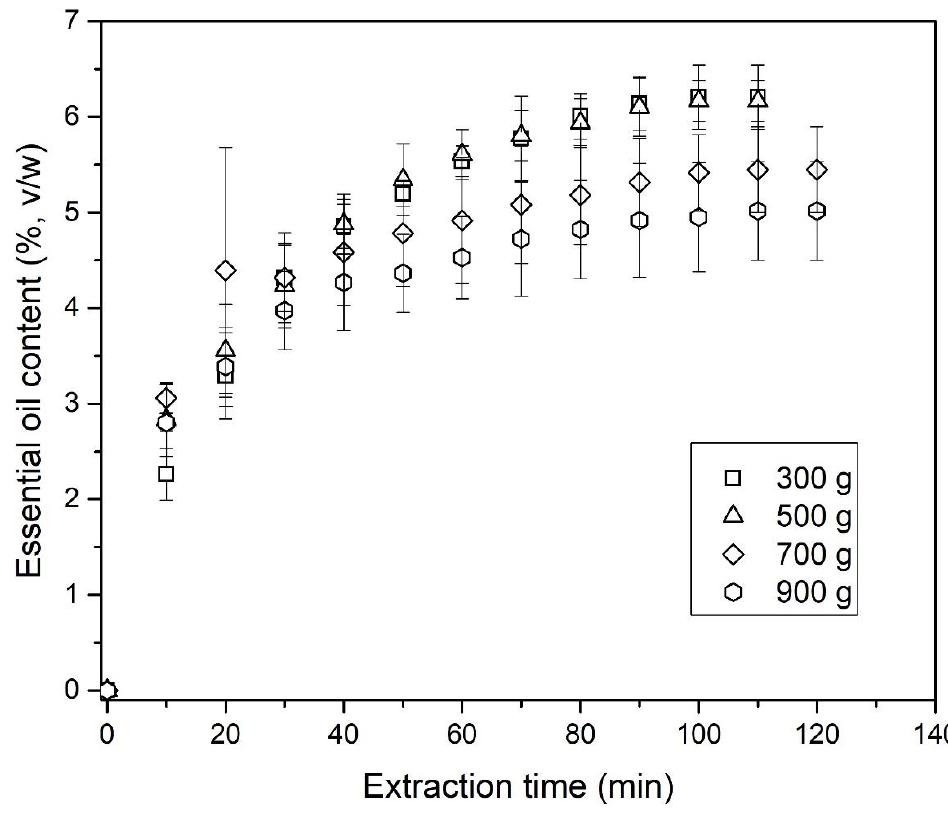
Figure 2. Effect of input sample weight over time in steam distillation.